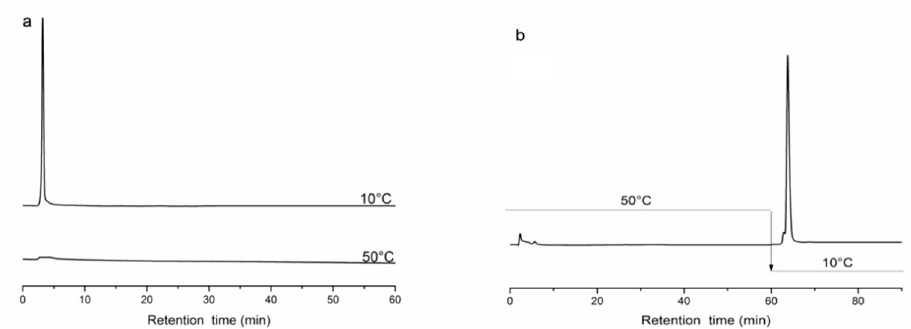
Figure 5. Chromatogram of bovine serum albumin (BSA) using a poly(NIPAAm- co -DEAEMA- co -tBAAm)-grafted silica column. ( a ) Chromatogram of BSA at 10 and 50 °C; ( b ) injecting the sample at 50 °C and changing the temperature to 10 °C at 60 min, flow rate 0.1 mL/min, detection wavelength 280 nm, sample size 5 μ L.